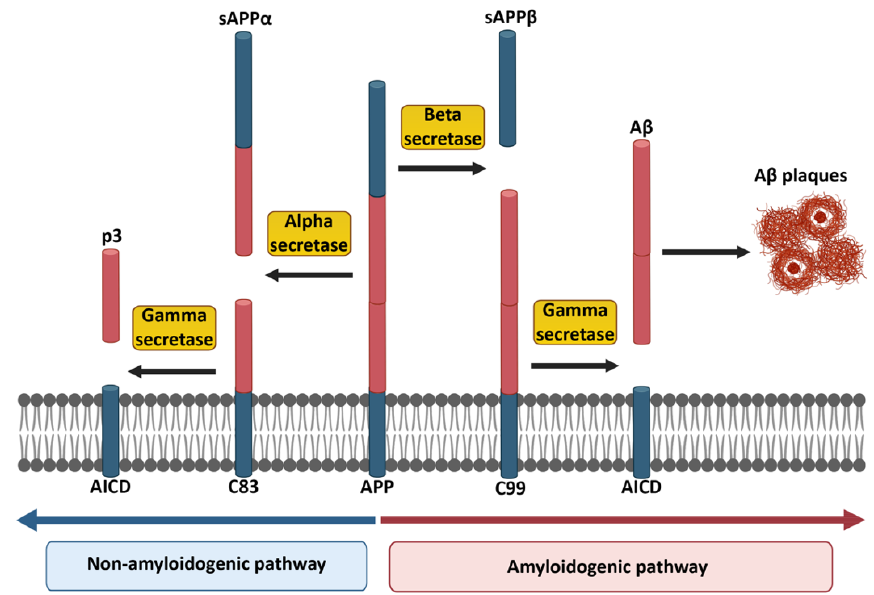
Figure 1. Non-amyloidogenic and amyloidogenic pathways in the cleavage of APP. The red part of APP indicates the potentially harmful A β portion, which appears at the end of the amyloidogenic pathway. Created partially with BioRender.com (accessed on 28 June 2021).